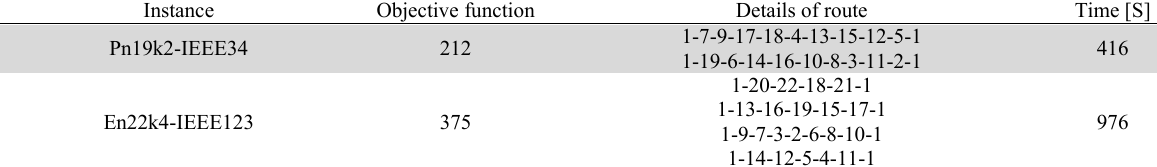
Benchmark case results with the transportation network approach